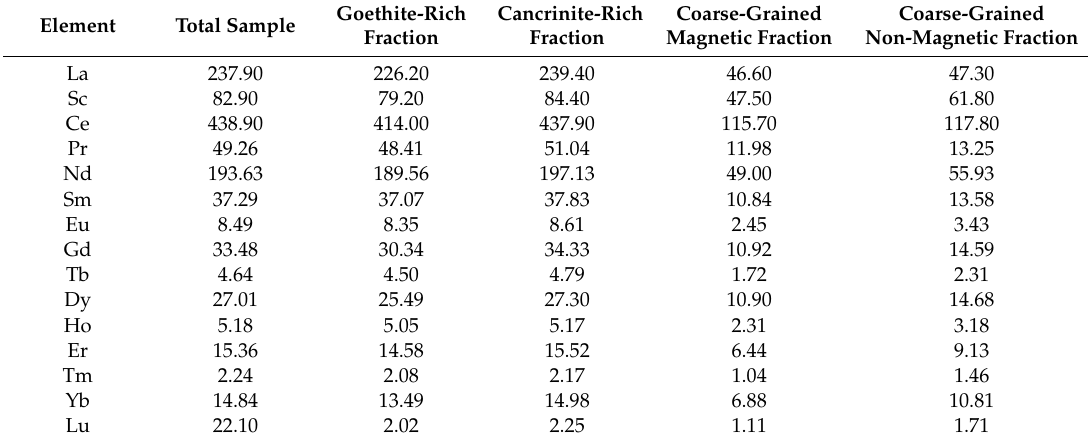
Table 4. REE concentrations (all in ppm) in the studied grain fractions.